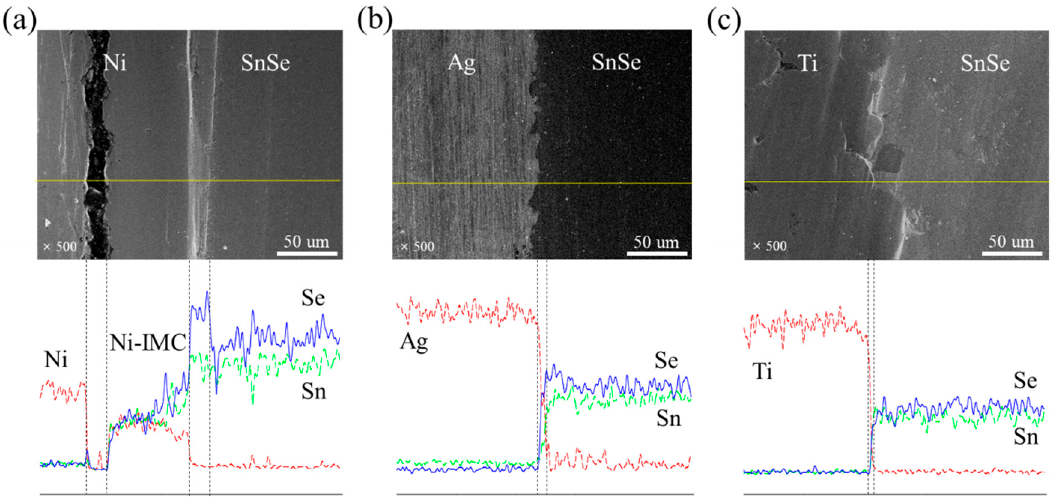
Figure 2. SEM (Scanning Electron Microscopy) images and EDS (Energy Dispersive Spectrometer) line scanning of single-layer metallization: ( a ) Ni; ( b ) Ag; and ( c )